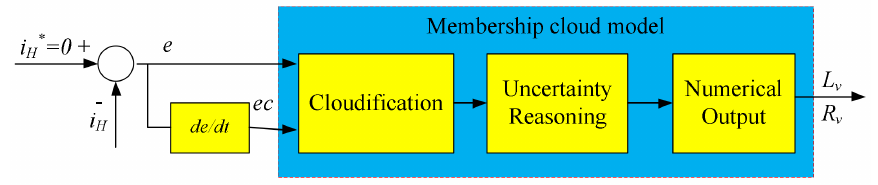
Figure 4. The adaptive virtual impedance from the membership cloud model.